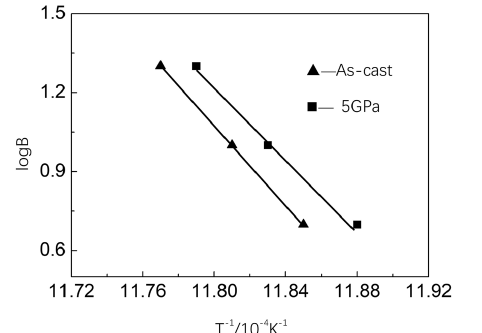
Fig.7 - Plots of log( B) ~ T -1 at 50% phase transformation volume fraction of Cu-Al alloy before and after high pressure treatment